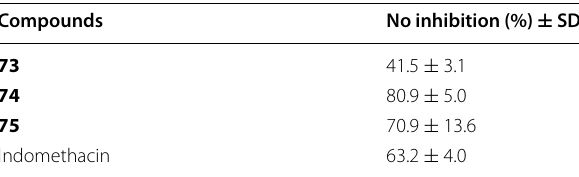
Table 24 Anti-inflammatory activities of synthesized